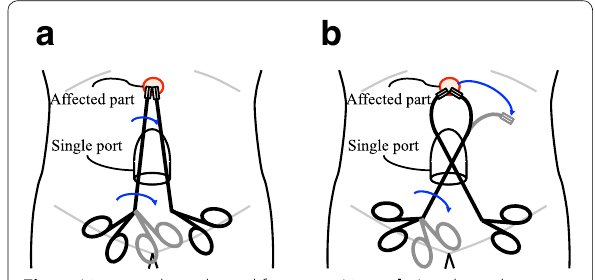
Fig. 1 Linear and arc-shaped forceps. a Linear. b Arc-shaped